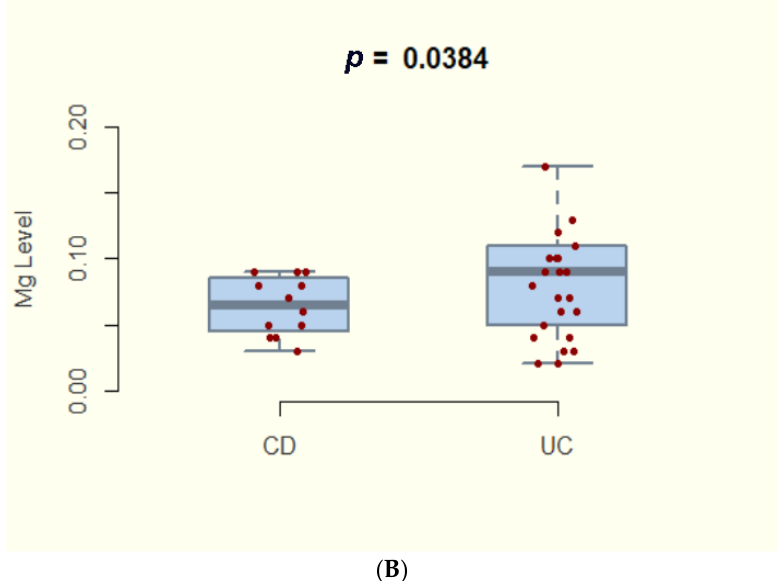
Figure 1. ( A ) Evaluating the difference in hair magnesium concentration between IBD (inflamma- tory bowel disease) patients and the control group. ( B ) Evaluating the difference in hair magnesium concentration between CD ( crohn’s disease )and UC (ulcerative colitis).